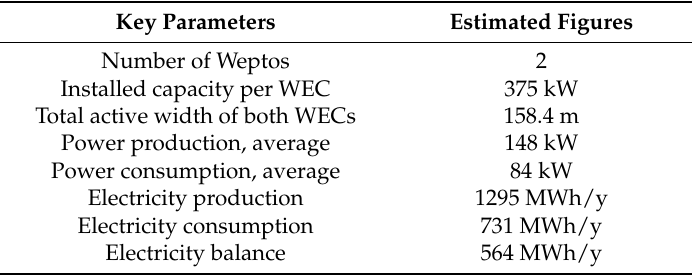
Figure 12. 4 Weptos configuration. Power balance during 8760 hours from 1 September 2016 to 31 August 2017. Pbal = Pprod − Pcons (blue), Batt_level: battery stored energy (orange), Energy Exceeding Batt_level (green): the energy that cannot be stored in the batteries, either because batteries are already full or because there is not enough energy to be stored, as it is all used for the demand. Table 6. Summary of results for 2 Weptos configuration.